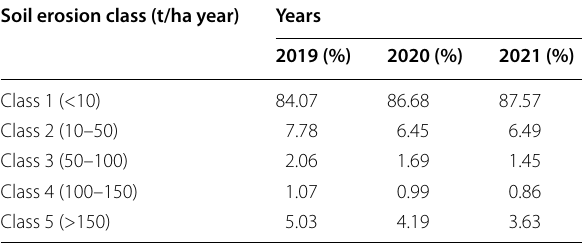
Table 2 Percentage of soil erosion classes under 3-year periods in the study